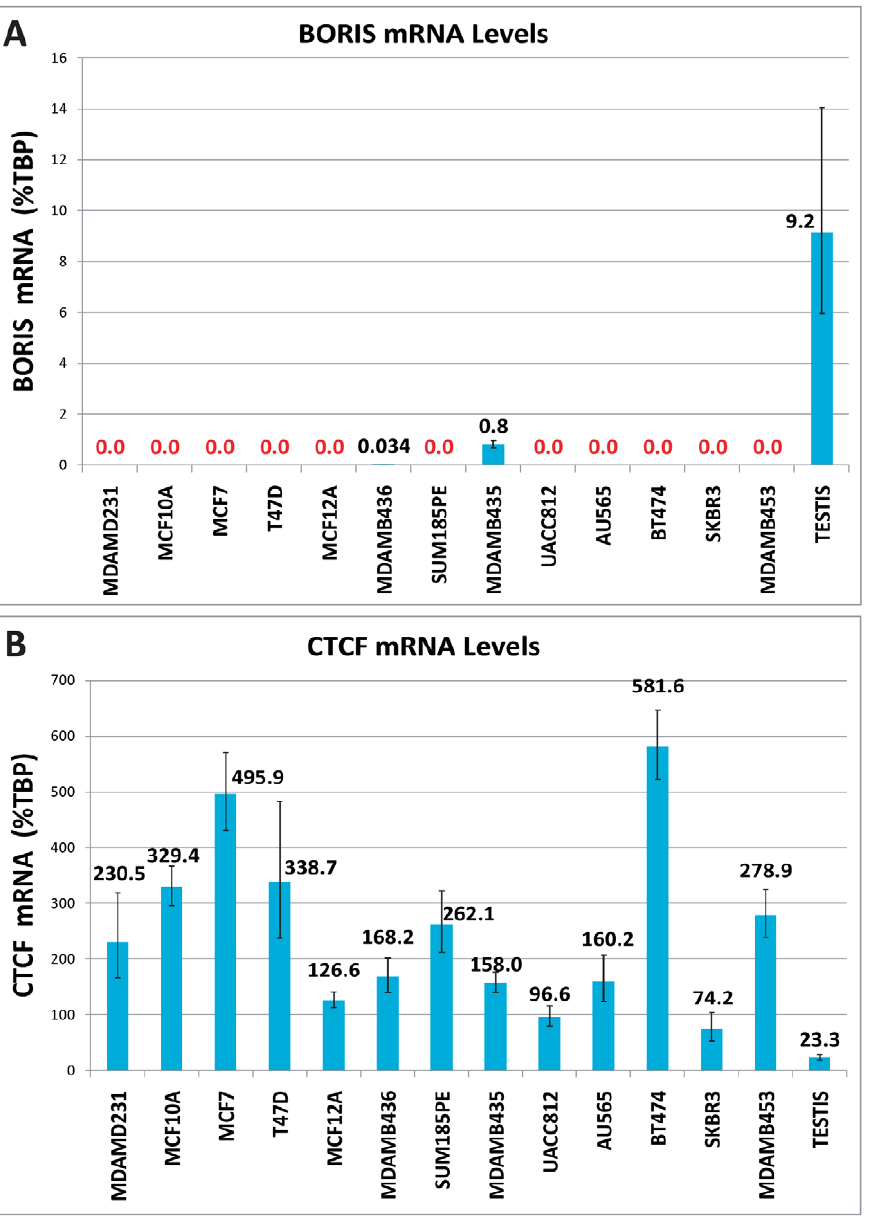
Figure 2. BORIS and CTCF mRNA levels in cell lines. Levels of (A) BORIS and (B) CTCF mRNA were measured by real time PCR in cell lines and testis (provided as a physiological control), and are reported relative to the levels of internal reference transcript TBP . BORIS mRNA was detectable in the breast cell line, MDAMB436, and in the melanoma-derived cell line, MDAMB435, but not in the remaining breast-derived cell lines. CTCF mRNA levels were near or above the levels of TBP mRNA in all cell lines. Testis expressed the lowest CTCF level, near the level of BORIS in this sample (note the differences in scale between the graphs).